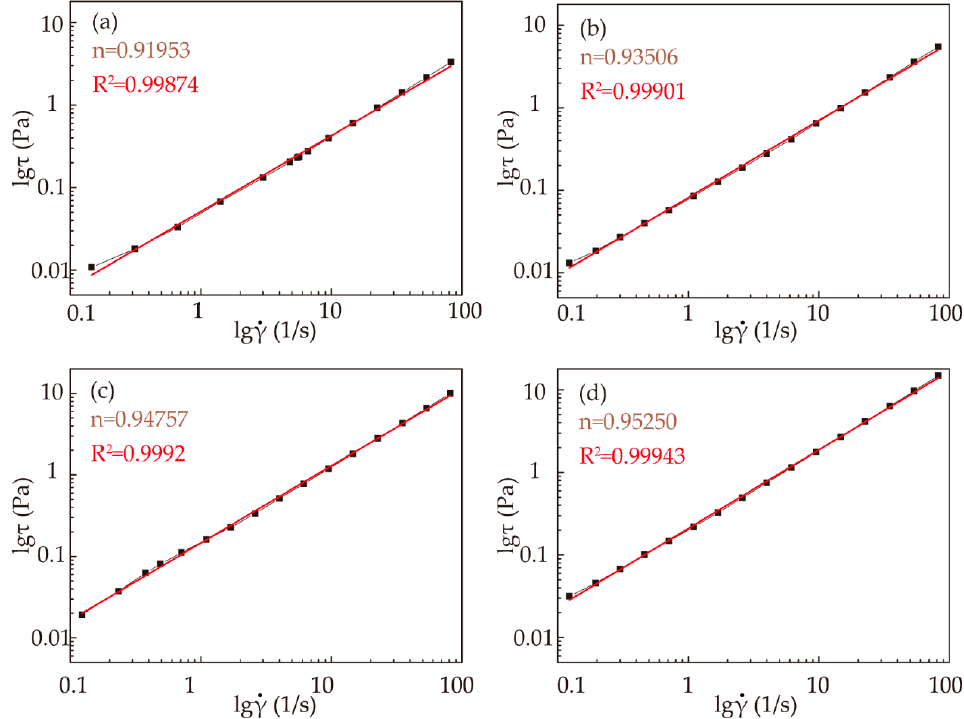
Figure 3. Rheological behavior fitting results of RSF solutions with different concentrations: (a) 19%; (b) 22%; (c) 25%; (d) 28%.